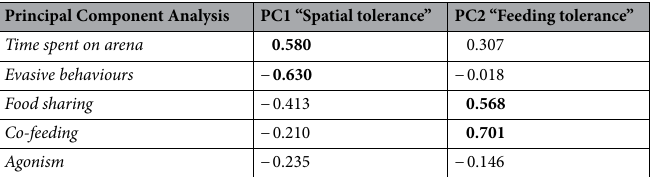
Table 1. Principal component analysis. The entries of the behaviours (italics) are loadings, with those above 0.5 highlighted in bold.